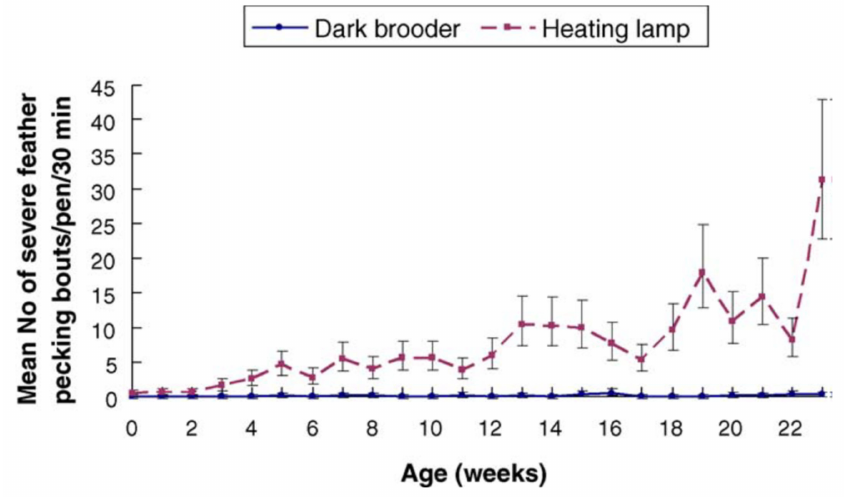
Figure 2. Mean number and SE of severe feather pecking bouts per pen per 30 min for the dark brooder pens and the heating lamp (i.e., non-brooded) pens